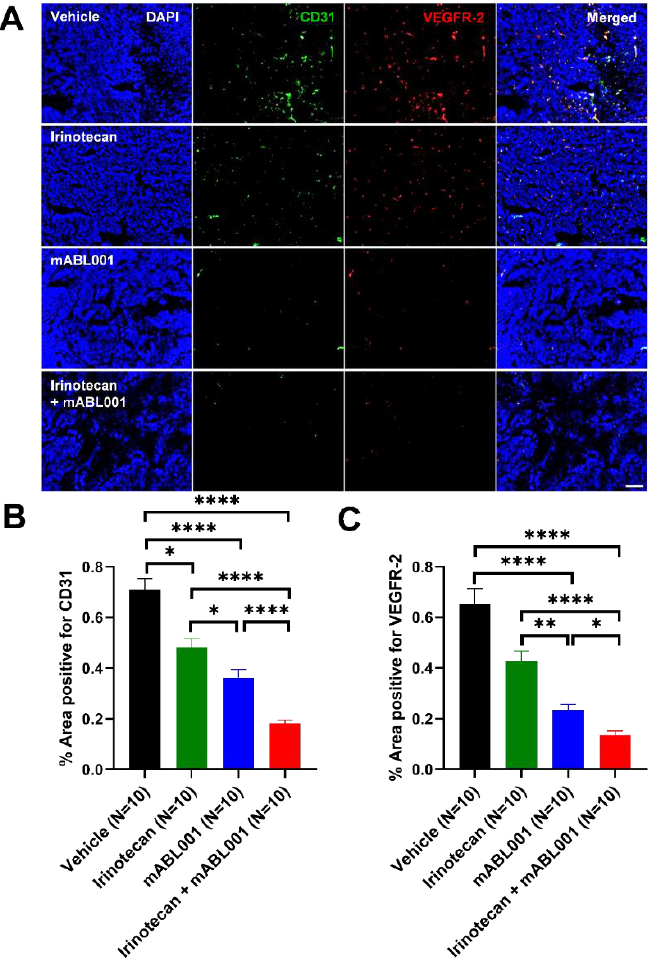
Figure 3. Combination therapy more potently regressed tumor blood vessels in SW620 xenograft model. Representative immunofluorescence images ( A ) show the tumor vasculature in SW620 tumor tissues stained for CD31, a generally conserved endothelial cell marker (green) and VEGFR-2 (red) with DAPI (blue). Most tumor blood vessels in vehicle group were stained and colocalized with both markers, CD31 and VEGFR-2. The area densities of CD31 ( B ) and VEGFR-2 ( C ) positive vessels were measured in each group. After irinotecan treatment, CD31 or VEGFR-2 positive tumor blood vessels were slightly regressed compared to vehicle treatment. However, after mABL001 or the combination treatment of mABL001 and irinotecan, CD31 and VEGFR-2 positive tumor vessels were significantly reduced ( B , C ). VEGFR-2 expression reduced more rapidly on tumor vessels. Scale bar indicates 200 µ m. Error bars: mean ± SEM. * p < 0.05, ** p < 0.01, **** p < 0.0001 by Kruskal–Wallis